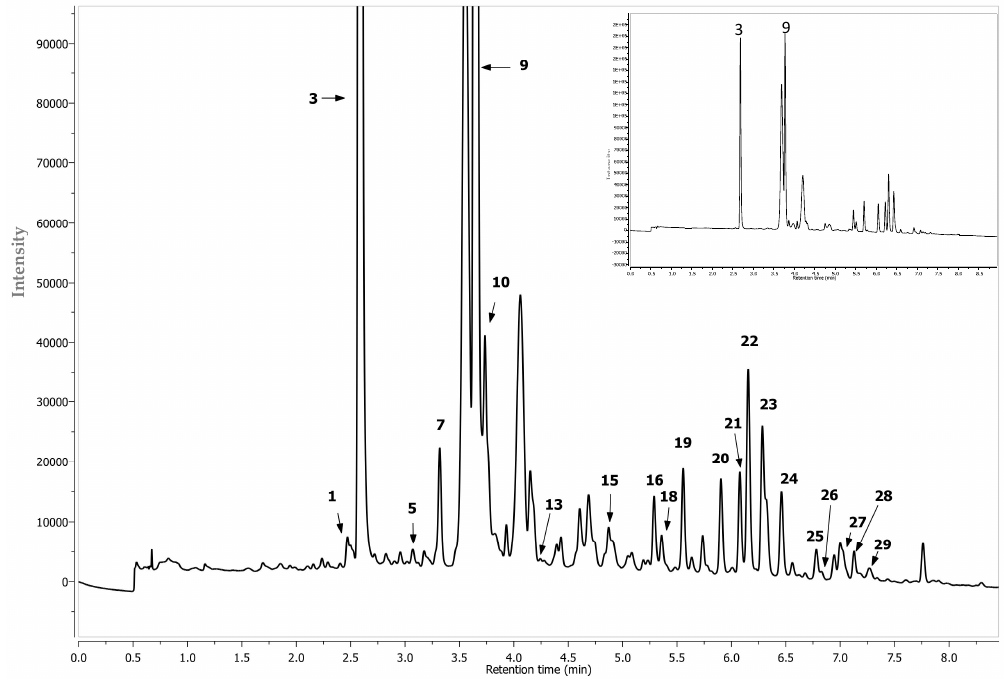
Figure 7. Segment from 0.0 to 9.0 min of LC-DAD chromatogram at 280 nm of chokeberry extracts. Peak number identities are displayed in Table 2.